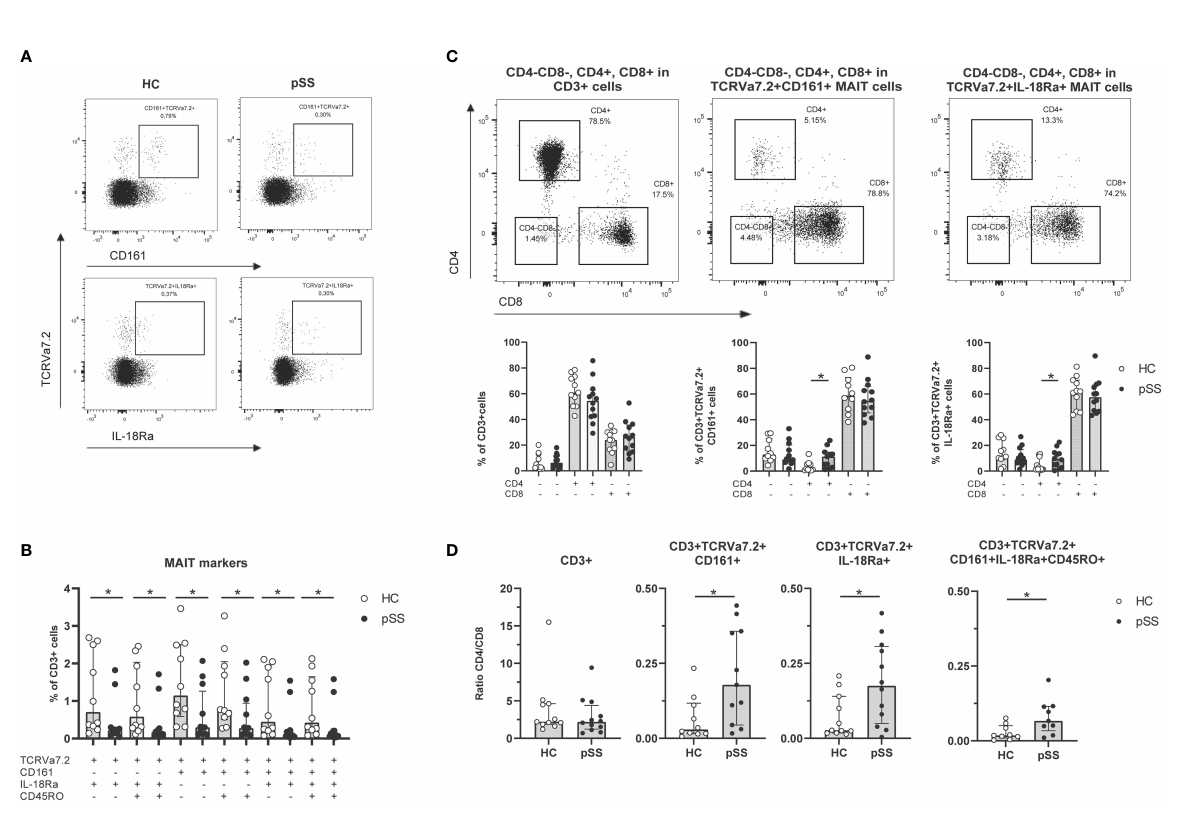
FIGURE 1 Reduced frequencies and shift in CD4/CD8 ratio of antigen-experienced CD161+/IL-18R a + MAIT cells in pSS patients. (A) Representative fl ow cytometry plots from a HC and a pSS patient of MAIT cell staining. Gates are shown of TCRV a 7.2+CD161+ and TCRV a 7.2+IL-18R a + within CD3 + cells. (B) MAIT cell subsets de fi ned by TCRV a 7.2 expression in combination with CD161, IL-18R a , and CD45RO, are shown as percentages of the CD3+ T cell population in pSS patients and controls. (C) Representative dot plots of CD4/CD8 staining of all CD3+ cells, CD161+ and